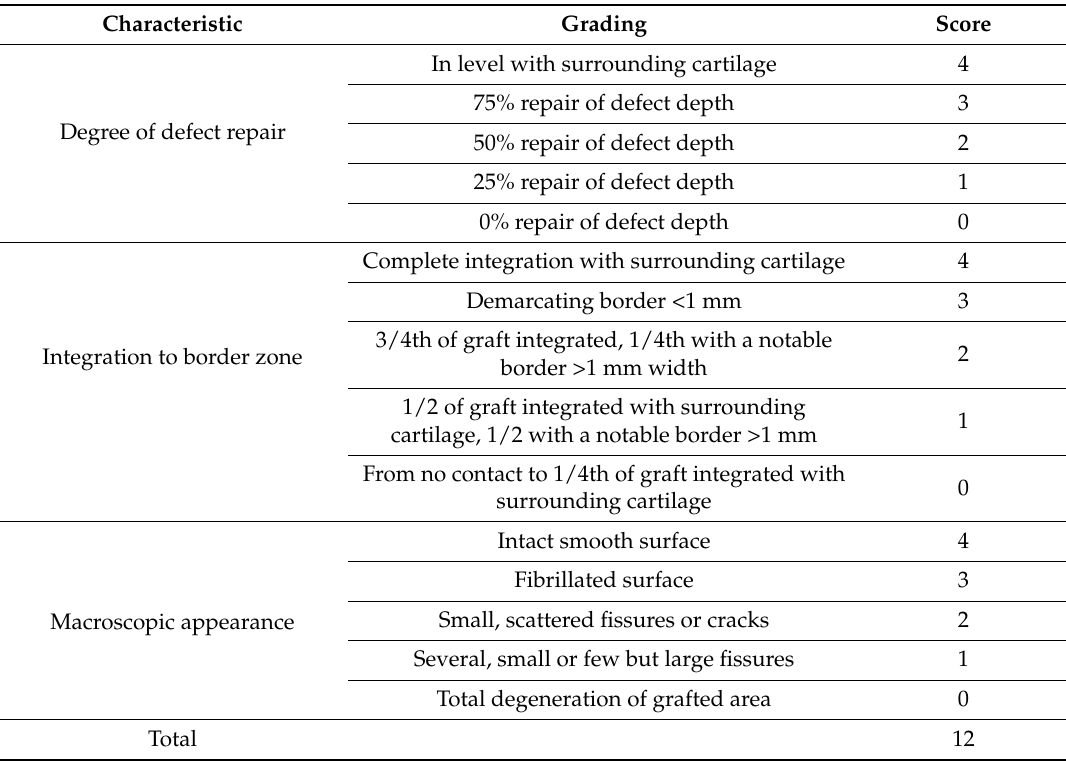
Table 2. Criteria of the ICRS macroscore used for rating of cartilage repair quality.